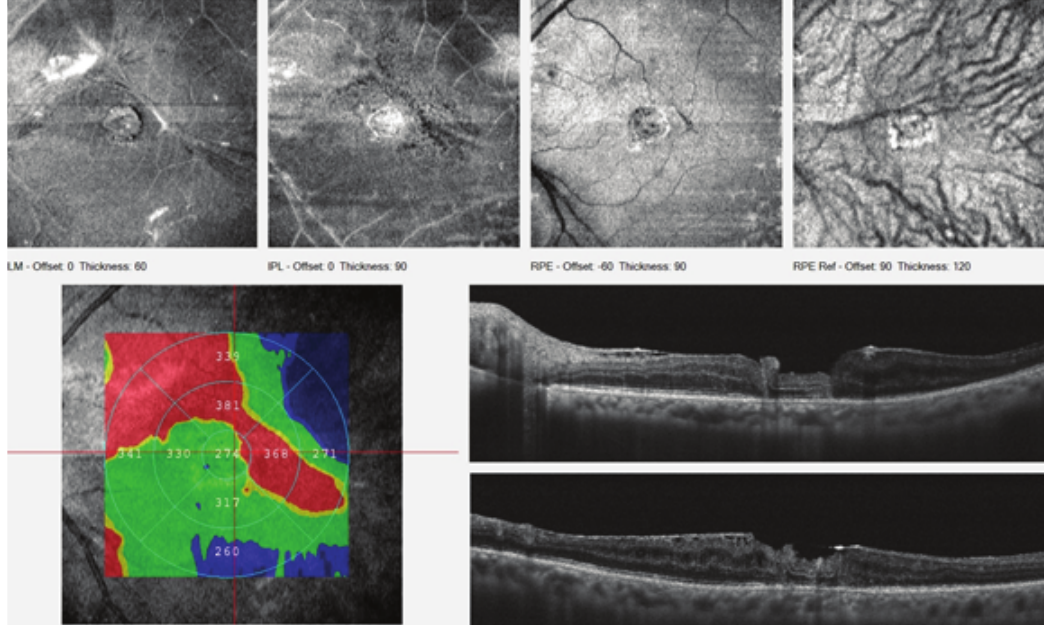
Figure 5. Patient 2; early postoperative OCT cross-line horizontal and vertical scans with graft tissue plugging the macular hole. The intraretinal architecture is